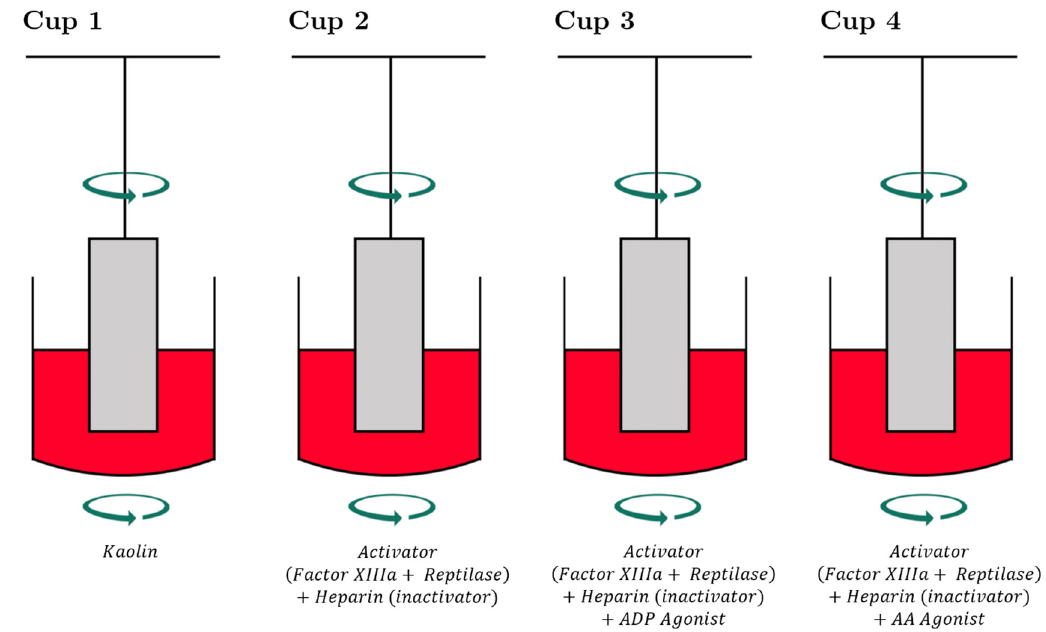
Figure 3. The analysis of platelet function requires four cups for Modified Thromboelastography with Platelet Mapping (TEG-PM ® ). In Cup 1 is a baseline kaolin TEG ® which describes control parameters. In Cups 2–4, heparin is added to neutralize thrombin which allows for isolation of platelet function in the presence of a pure fibrin clot. Reptilase and Factor XIIIa are added to Cups 2-4 to enhance fibrinogen and fibrin formation. Therefore, the additions of ADP in Cup 3 and AA in Cup 4 allow selective and respective activation of isolated ADP and AA receptors which then create an isolated pure fibrinogen/fibrin-platelet clot [109,121].